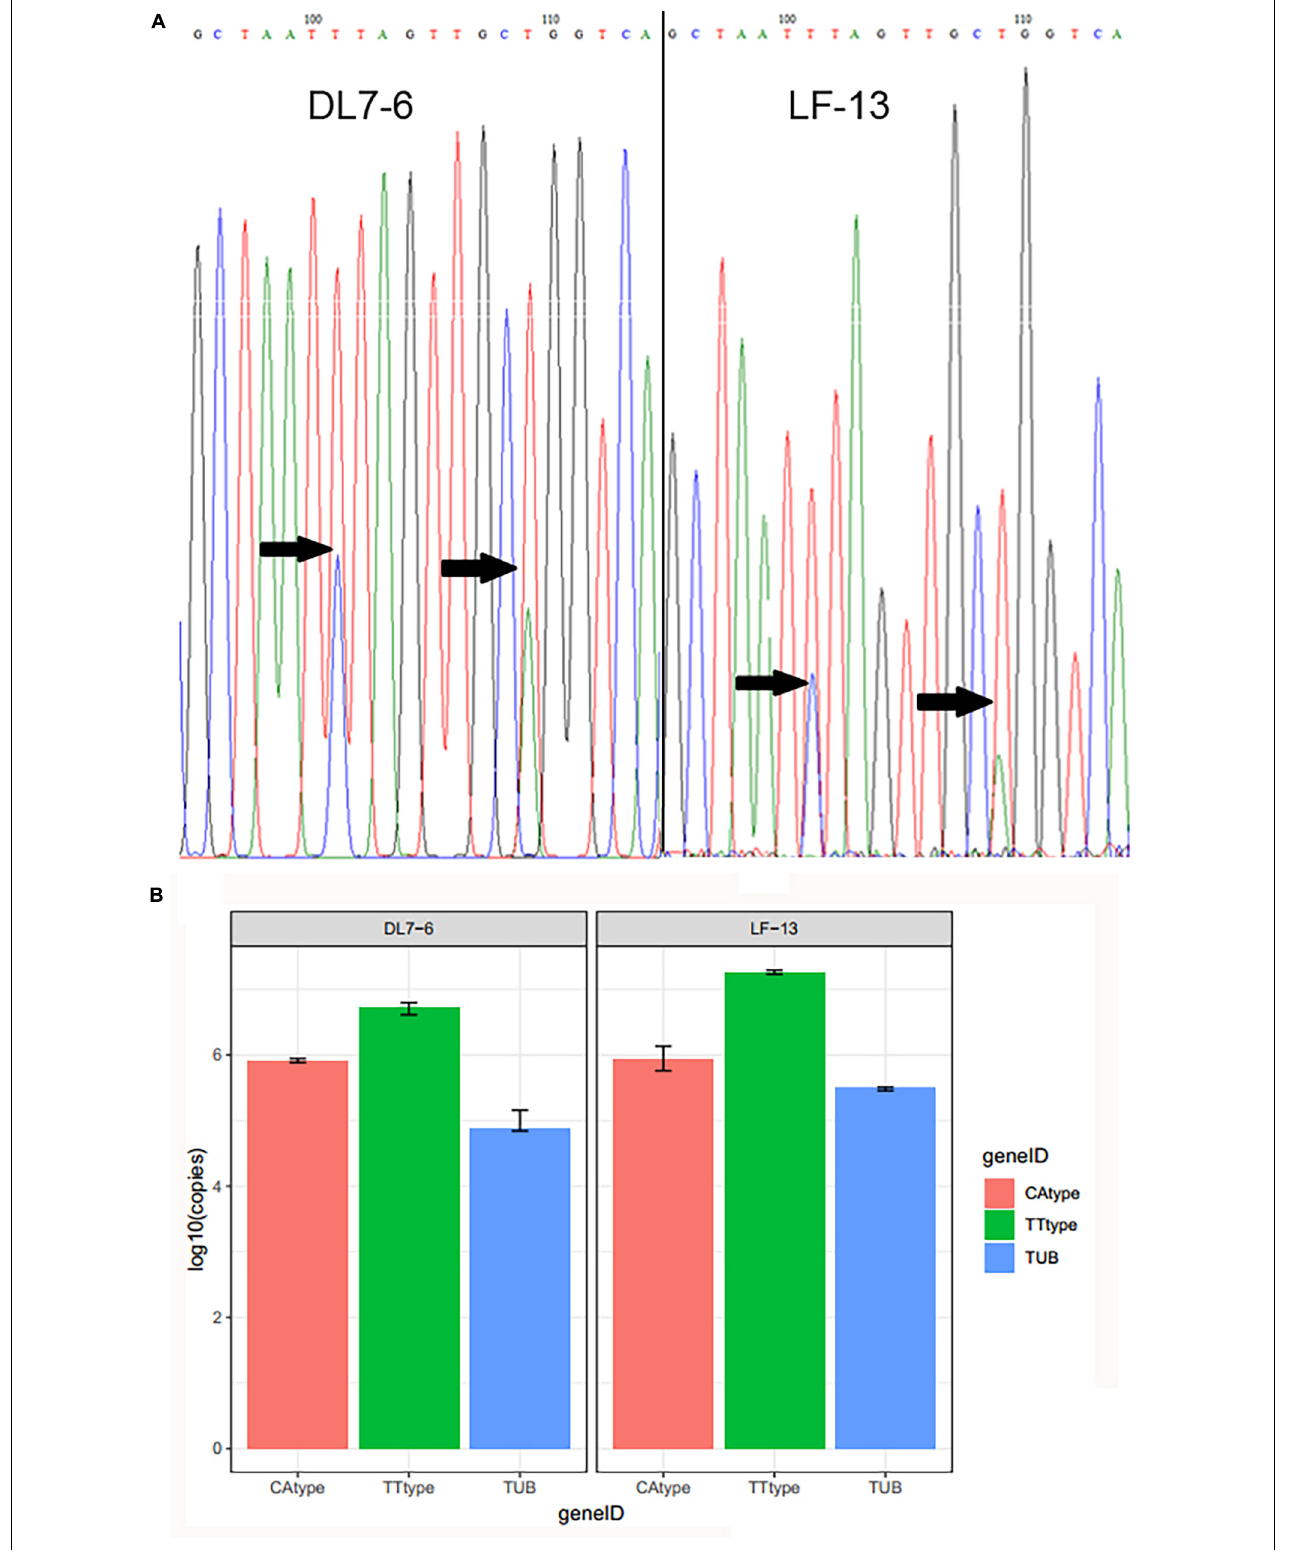
FIGURE 1 | (A) Heterozygous sites of mitochondrial gene atp6 and (B) copy numbers of higher peak and lower peak sequences relative to the reference nuclear tub gene in samples DL7-6 and LF-13 from Yunnan.